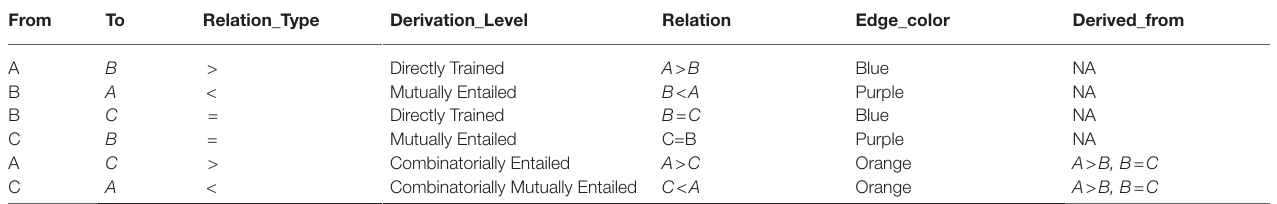
TABLE 2 | RelationTrain output for three stimulus mixed relation network.